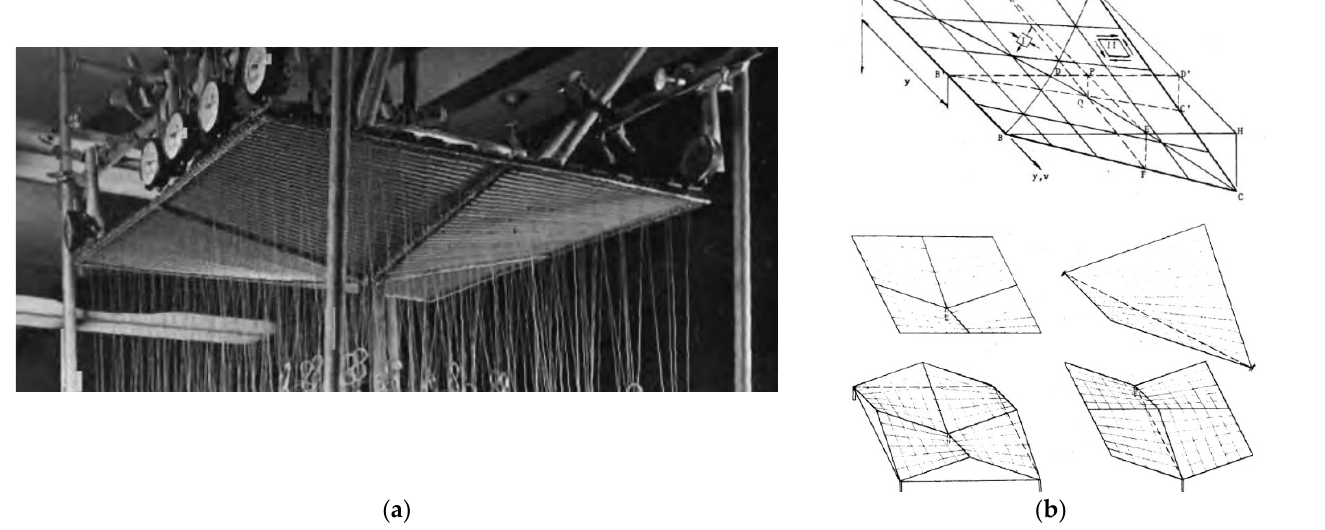
Figure 4. Hyperbolic paraboloid shells: ( a ) geometric models; ( b ) umbrella structures of four quarters.